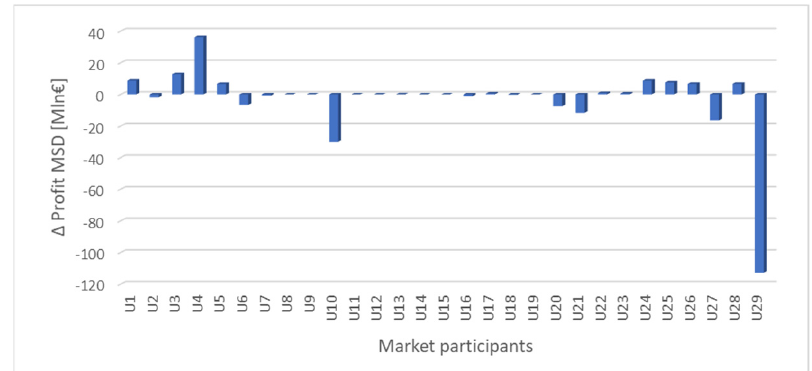
Figure 17. MSD profit increase when the RR auction is in place.